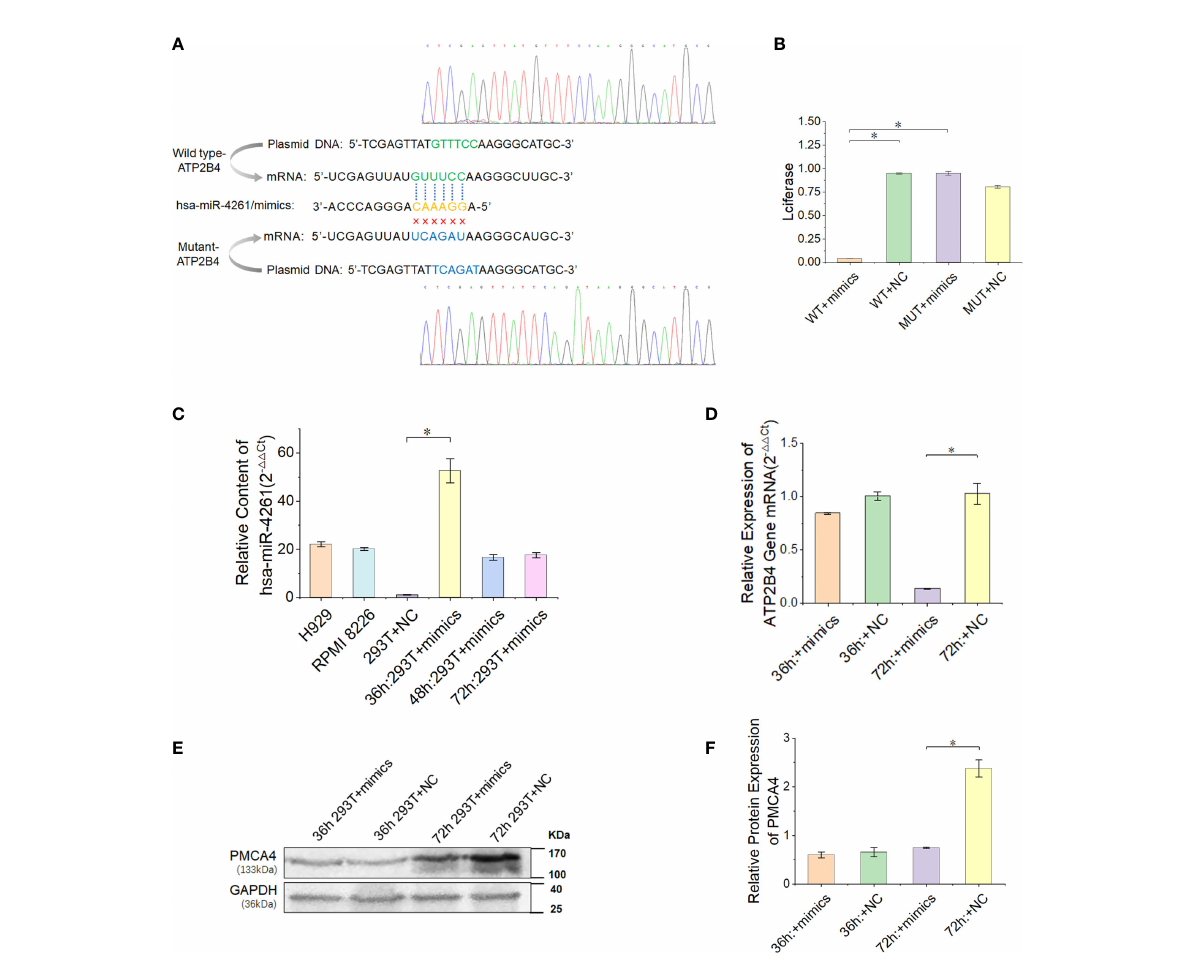
FIGURE 5 MiR-4261 can target and regulate the ATP2B4 gene and reduce the expression of PMCA4 protein. (A) Schematic diagram of the predicted miR- 4261 binding site in the 3 ’ -UTR of ATP2B4 mRNA. (B) Dual-luciferase reporter assay. The 3 ’ -UTR fragments (wild-type and mutant sequences) of ATP2B4 were cloned into the psiCHECK-2 vector and then cotransfected with miR-4261 mimics or NC. Comparison of relative fi re fl y/Renilla luciferase activity between the wild-type (WT) and negative control (NC) groups ( P WT+mimics vs. WT+NC = 1.9E-4, and P WT+mimics vs. MUT+mimics = 1.4E-3). (C) The content of miR-4261 in HEK293T cells 36, 48, and 72 hours after transfection of miR-4261 mimics ( P = 2.7E-2) and the endogenous content of miR-4261 in H929 cells and RPMI8226 cells. (D) The mRNA level of ATP2B4 was reduced by miR-4261, and the